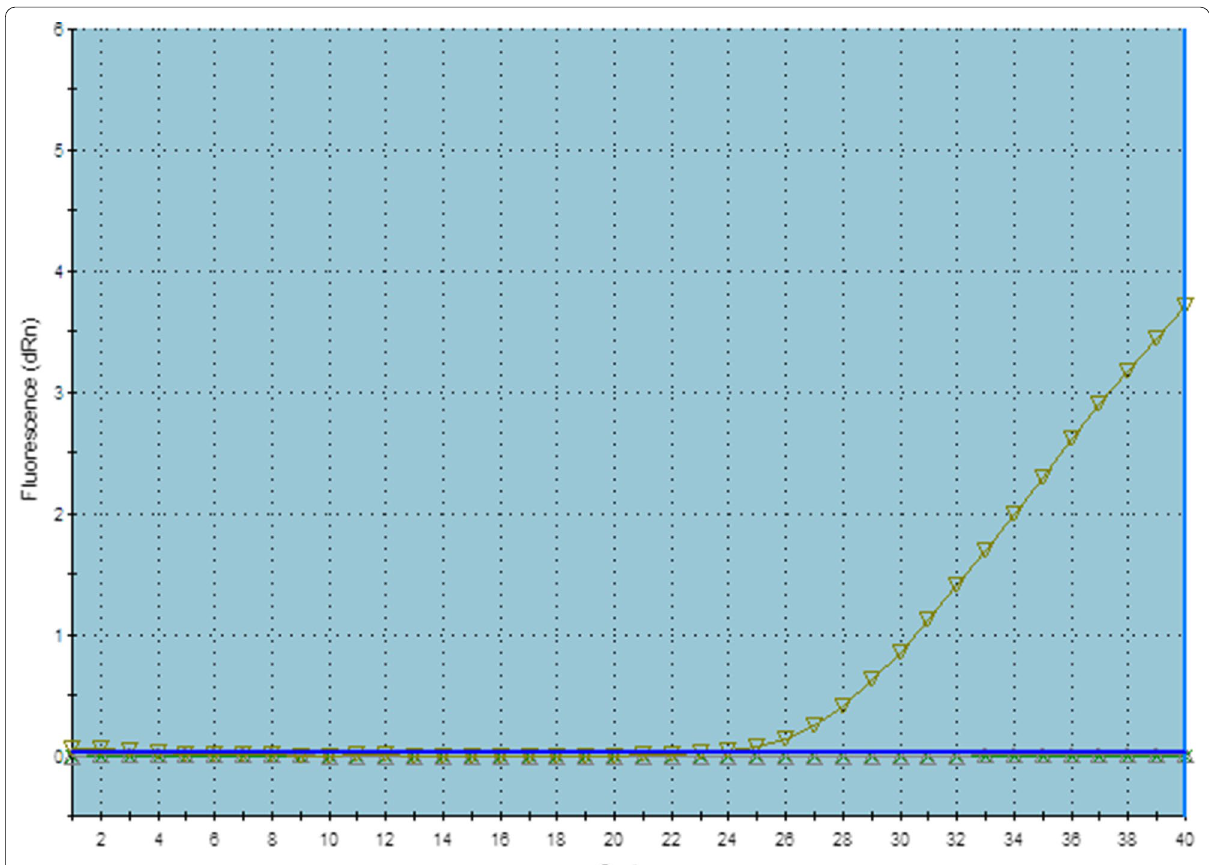
Fig. 3 Amplification plot curve showing a case with TT homozygous genotype for DVWA gene SNP ( rs11718863 ). It shows amplification of T allele with no amplification of A allele. T allele is represented as